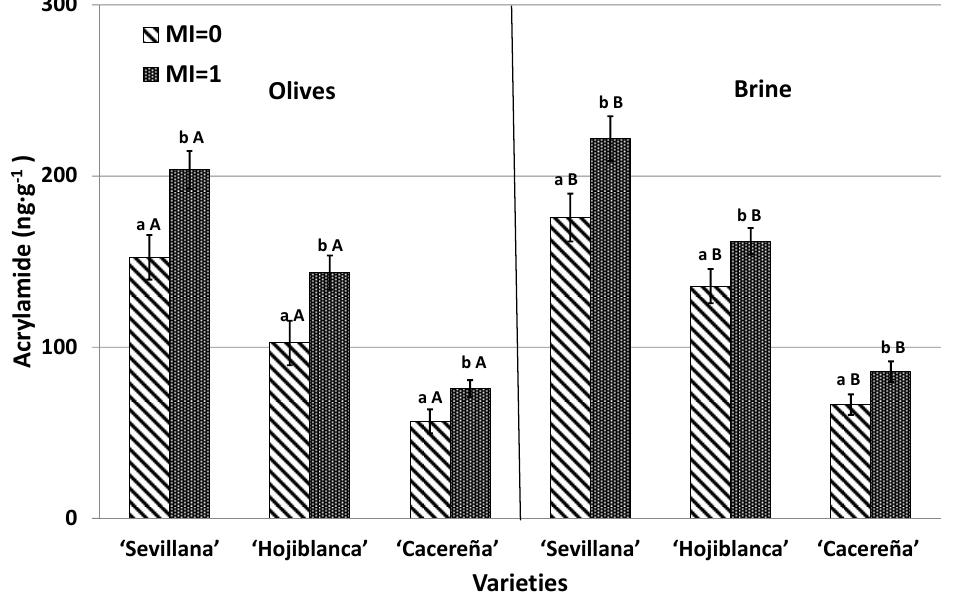
Figure 2. Acrylamide content (ng g − 1 ) in olives and brine obtained from different olive varieties harvested at two different olive maturation indexes (MI = 0 and MI = 1) and subjected to Californian-style green table olive processes. Results are expressed as the mean ± SD (standard desviation) of five sample replicates. Superscript indicates significant statistical differences between olives maturation stages for each olive variety (Tukey test, p < 0.05). Different capital letters in the same columns indicate significant statistical differences between olives and brine solution for each variety and maturation index (Tukey’s test, p < 0.05).